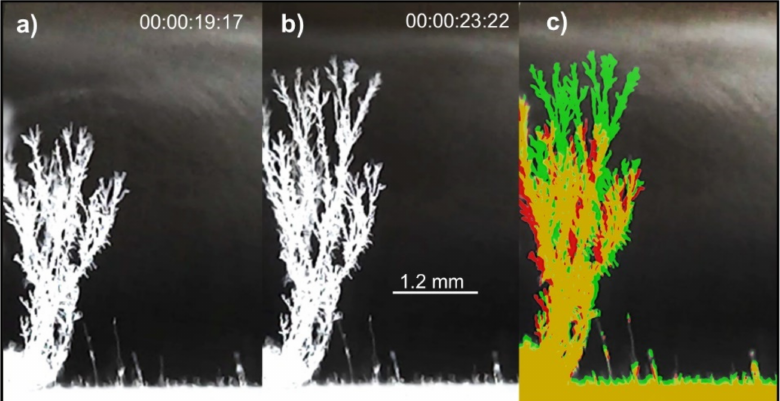
Figure 6. Dendrites and needle growth patterns. ( a , b ) Frames from the same area, taken a few seconds apart. ( c ) Combined ( a , b ) images with artificial colors: ( a ) red; ( b ) green. The ochre areas are where the colored pixel areas in ( a , b ) coincide. Note the dendrite displacement, upwards and to the right, where the cloud penetrates closer to the ice bed. Needles at the bottom of the pictures show only the non-uniform radial growth already presented in detail in Figures 4 and